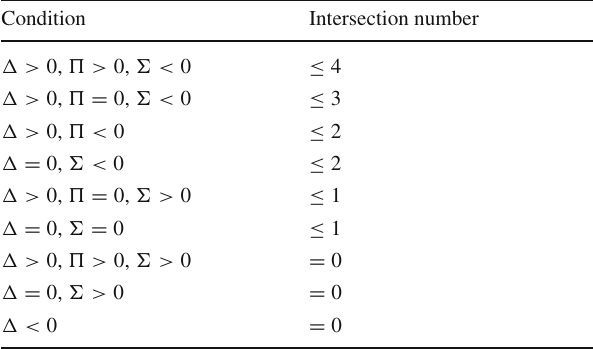
Table 3 Constraints on the intersection number for the critical points